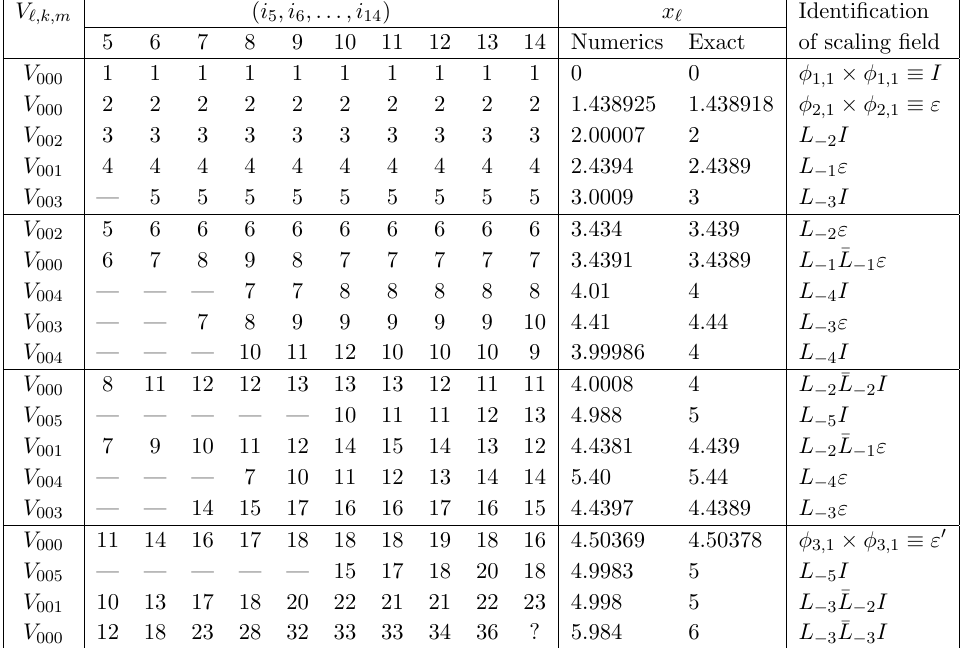
Table 1 . Conformal spectrum in the sector V 0 , for Q = 1